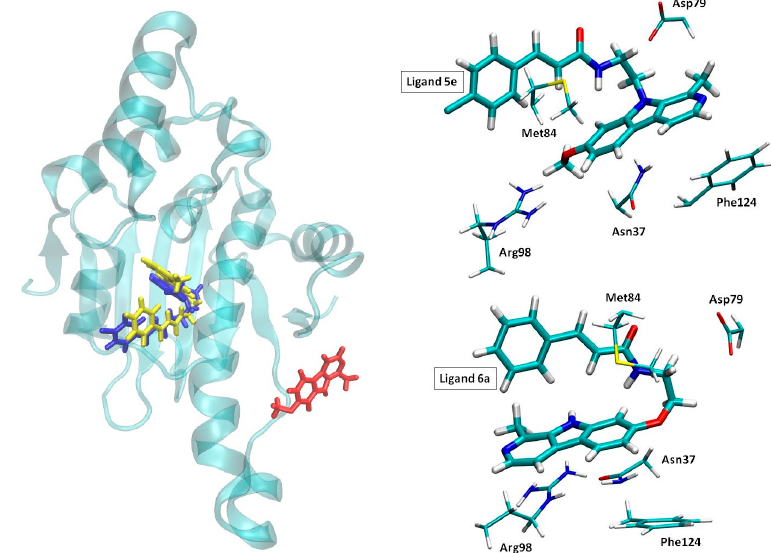
Figure 3. Binding positions of ligands 5e (in blue) and 6a (in yellow) within the ATP binding site in Pf Hsp90 and harmine (in red) outside of it (left). The interaction of 5e (top right) and 6a (bottom right) with the relevant binding site